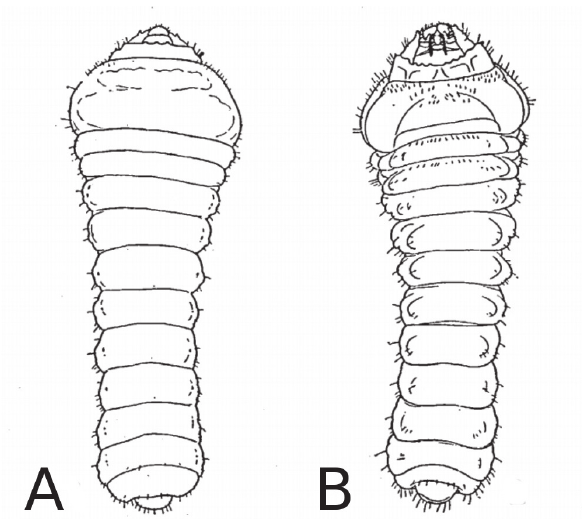
Figure 2. A freshly hatched larva of Morimus asper asper : A dorsal view B ventral view (Pavan 1948b).